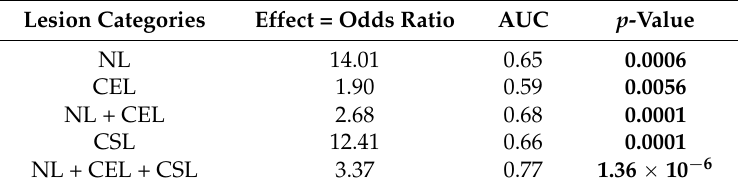
Table 2. Logistic Regressions of LGN volume reduction and ipsilateral lesion count along the optic radiation. Effect = Euler’s number to the power of the coefficient of the independent variable. AUC = Area under the ROC curve. p -value = p -value calculated with the Wald test. All values rounded to two decimal places, if needed ( p -values to four decimal places). All p -values below 0.05 are accentuated in bold print. Results were not corrected for multiple